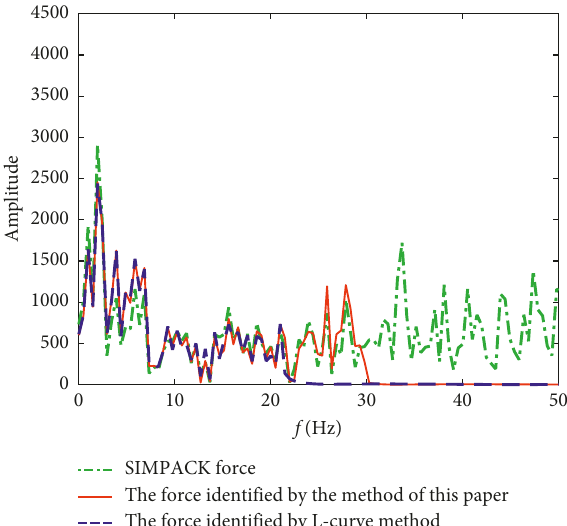
Figure 36: Amplitude-frequency curve of the two methods for F identification when the noise level is 4